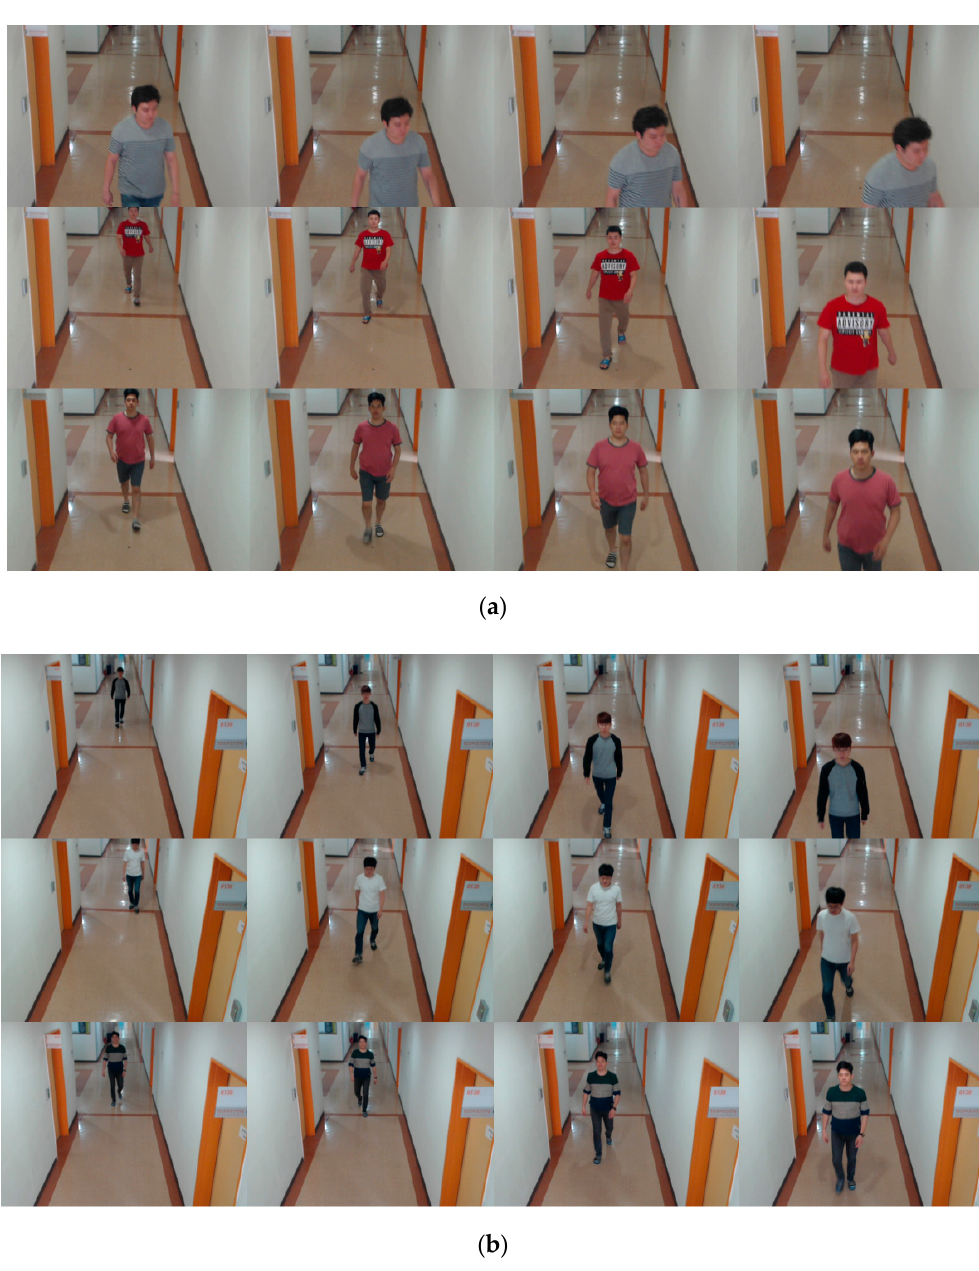
Figure 3. Representative Dongguk face and body dataset version 2 (DFB-DB2) images captured by ( a ) Logitech BCC950 camera and ( b ) Logitech C920 camera.